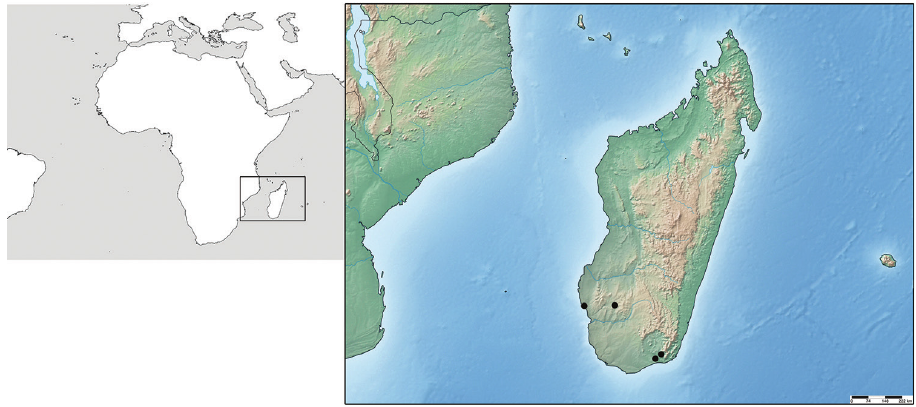
Figure 4. Known distribution of Ischiodon astales sp.